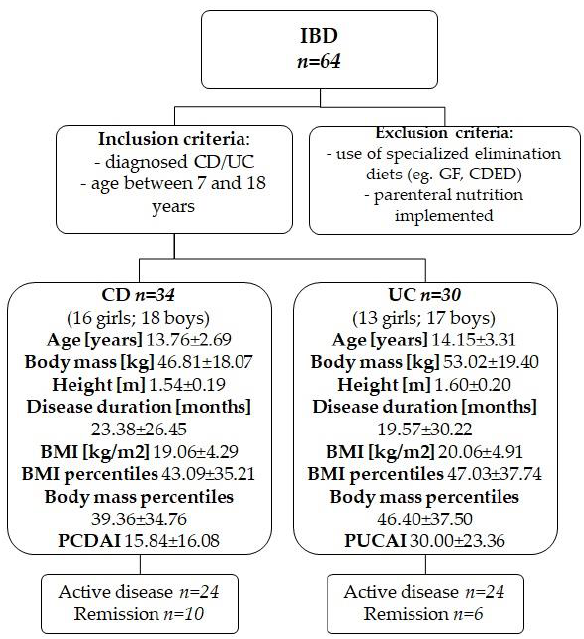
Figure 1. Characteristics of the study group (CD—Crohn’s disease, UC—ulcerative colitis). PCDAI— Pediatric Crohn’s Disease Activity Index; PUCAI—Pediatric Ulcerative Colitis Activity Index; GF— gluten-free diet, CDED—Crohn’s Disease Exclusion Diet; BMI—body mass index; IBD—inflammatory bowel disease. There were no statistical differences between the